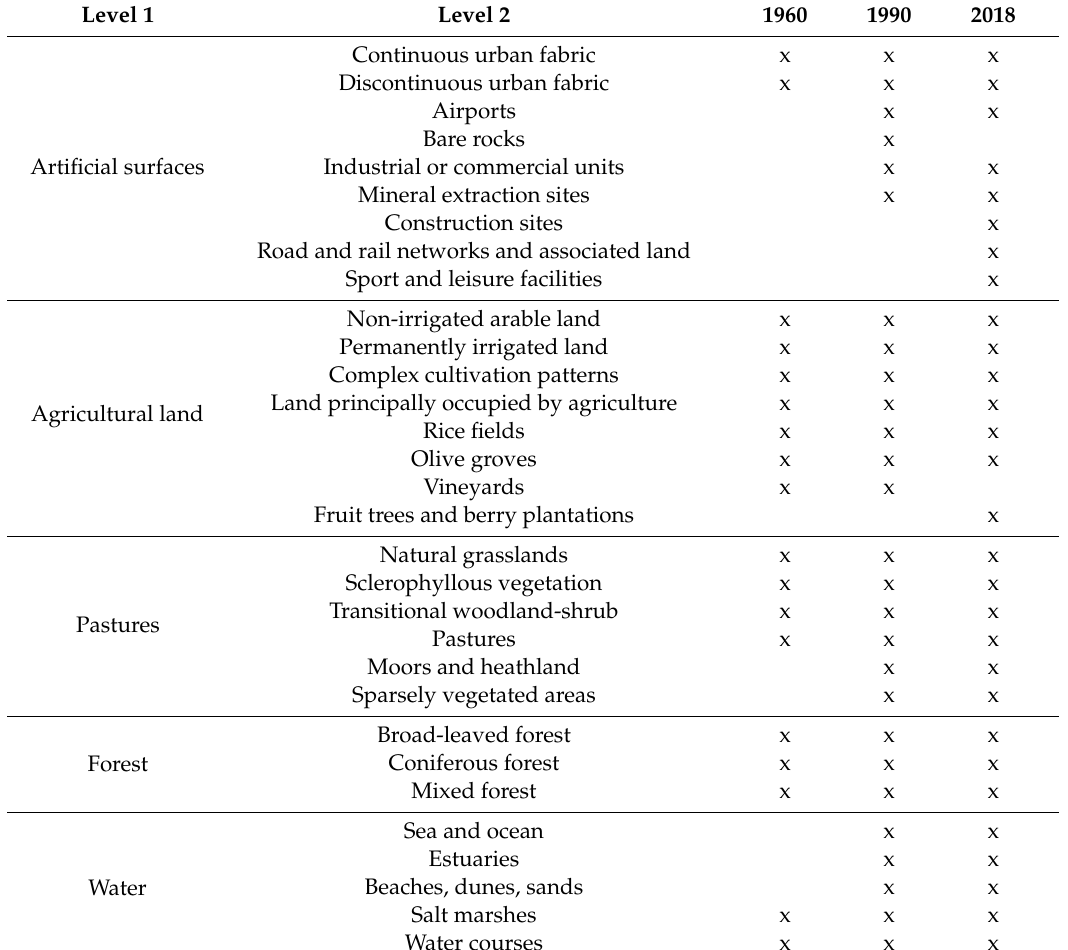
Table 3. Land cover nomenclature used in the present